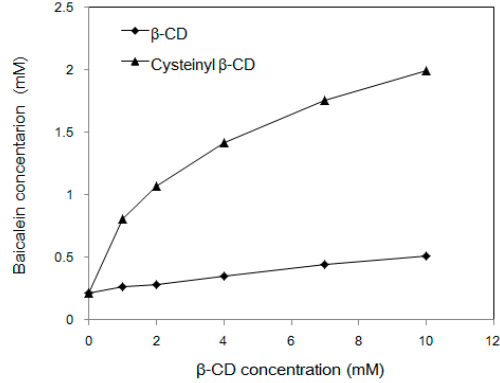
Figure 3. Phase solubility diagrams of baicalein with cysteinyl β -CD and β -CD in aqueous solution at 25 °C.